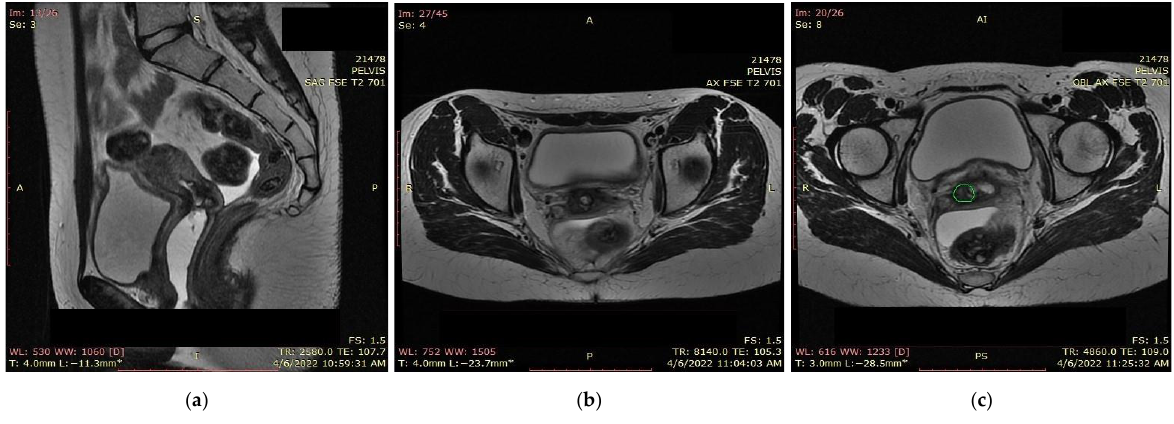
Figure 14. ( a ) MRI and ( b , c ) CT: almost completely undetectable lesion post-radiotherapy and chemotherapy response with the persistence of an involute area of necrosis and ulceration situated at on the topography of the former tumor (the green highlighted area).